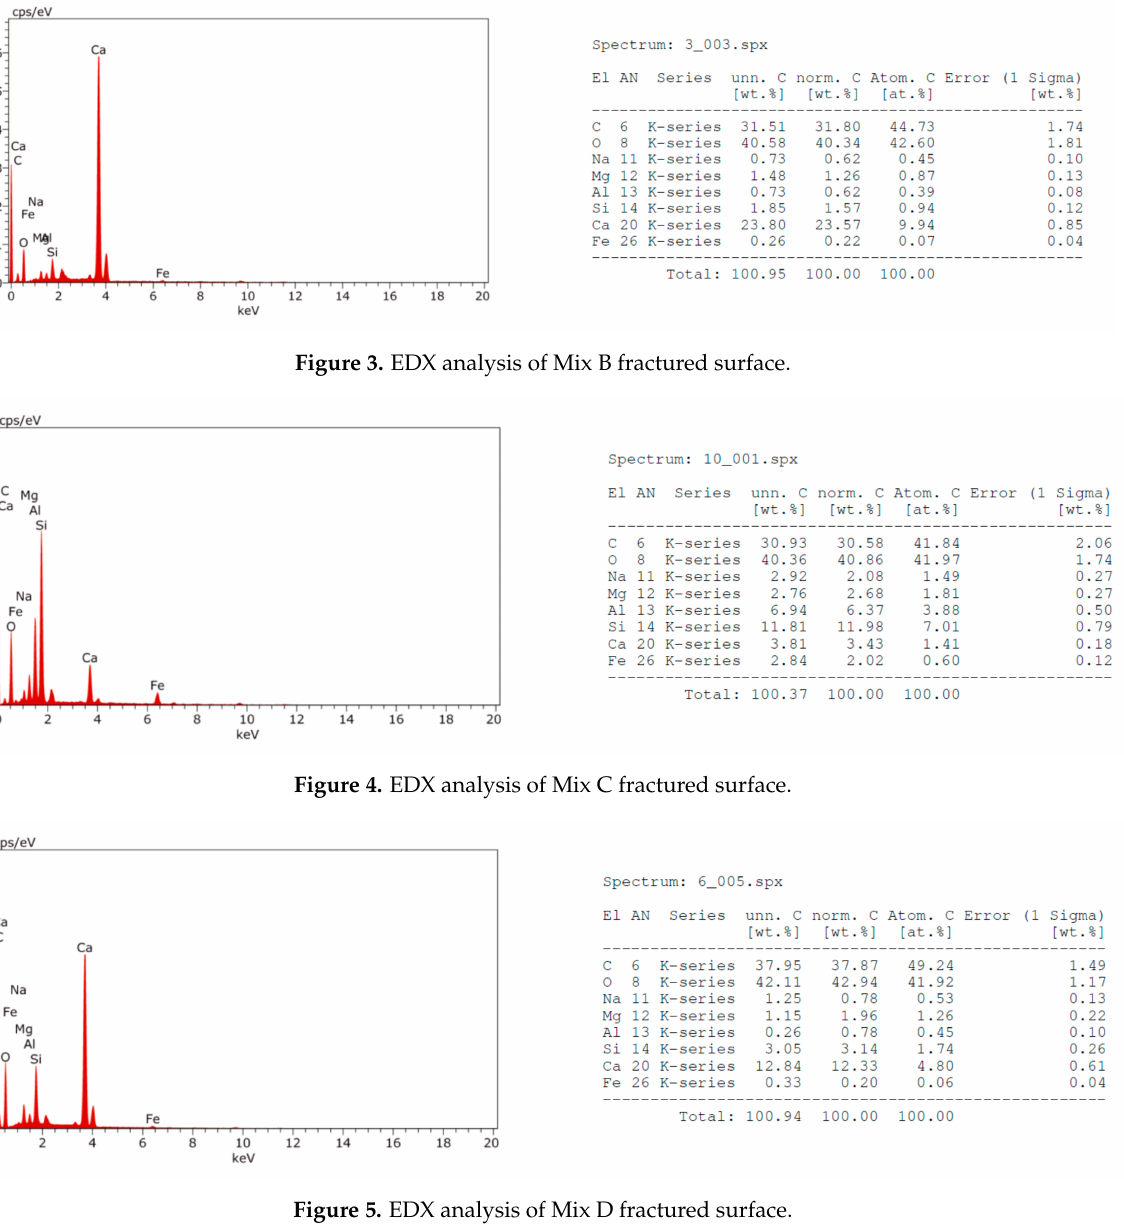
Figure 5. EDX analysis of Mix D fractured